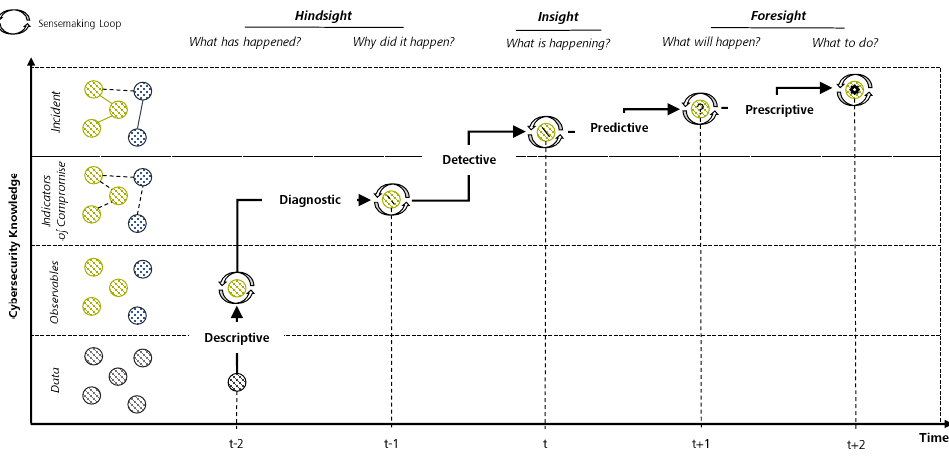
Figure 1. Cybersecurity knowledge